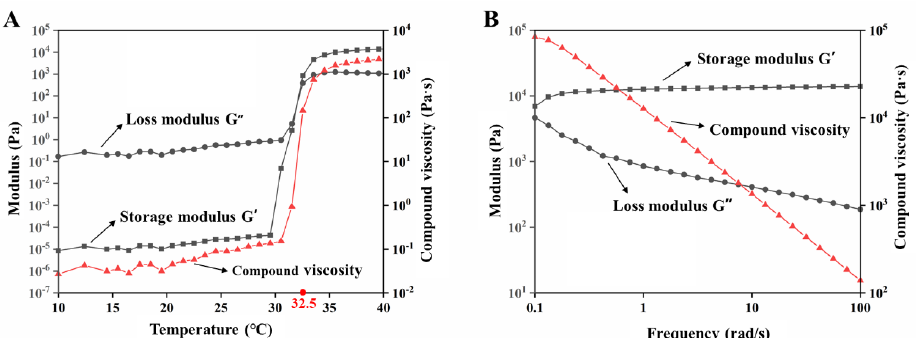
Figure 3. Rheological properties of EDA TSGs. ( A ) The profiles of storage modulus (G′), loss mod- ulus (G″) and compound viscosity of EDA TSGs at 10 − 40 °C with the shear frequency of 6.28 rad/s, the strain amplitude of 0.05%, and the heating rate of 1 °C/min. ( B ) The profiles of storage modulus (G′), loss modulus (G″) and compound viscosity of EDA TSGs at body temperature of 37 °C with the range of 0.1 − 100 rad/s and the strain rate of 0.05%.